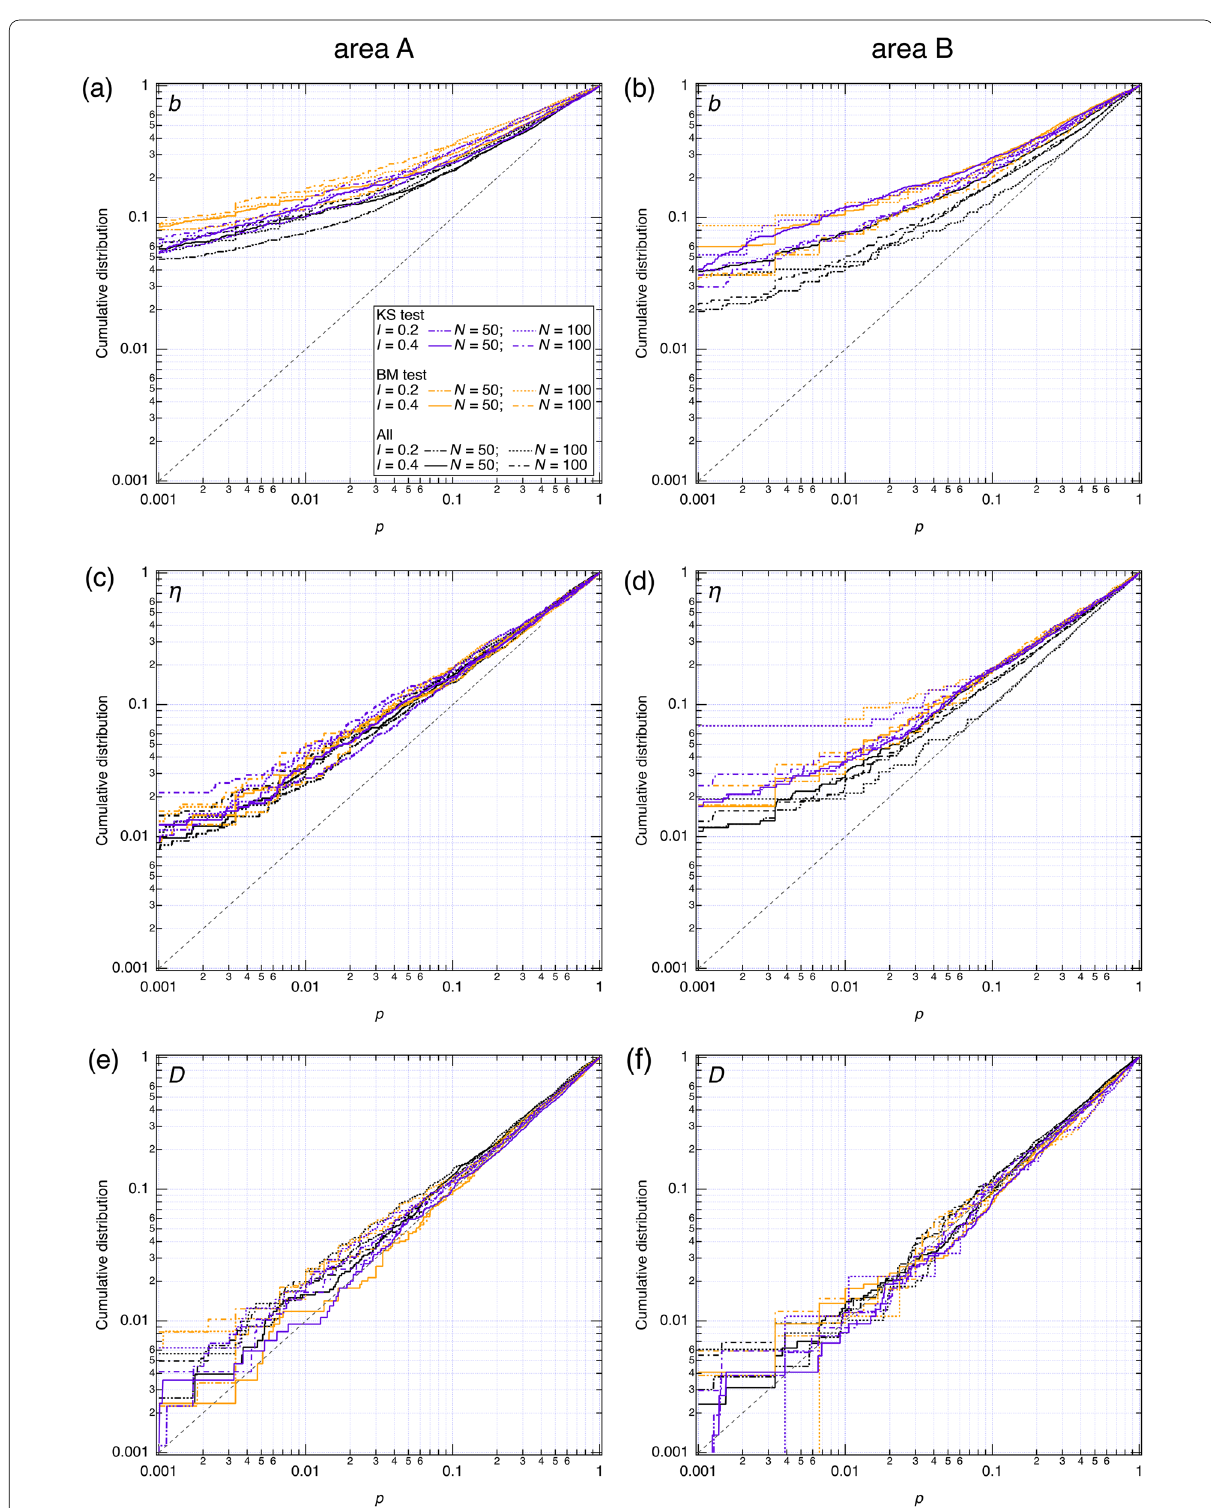
Fig. 6 Cumulative distributions of the p -values obtained from the statistical tests. The overall results, including the results of single index values, are shown in black, and the individual results of the KS and BM tests are shown in purple and orange, respectively. a , b b ; c , d η ; e , f D . Left, area A; right, area